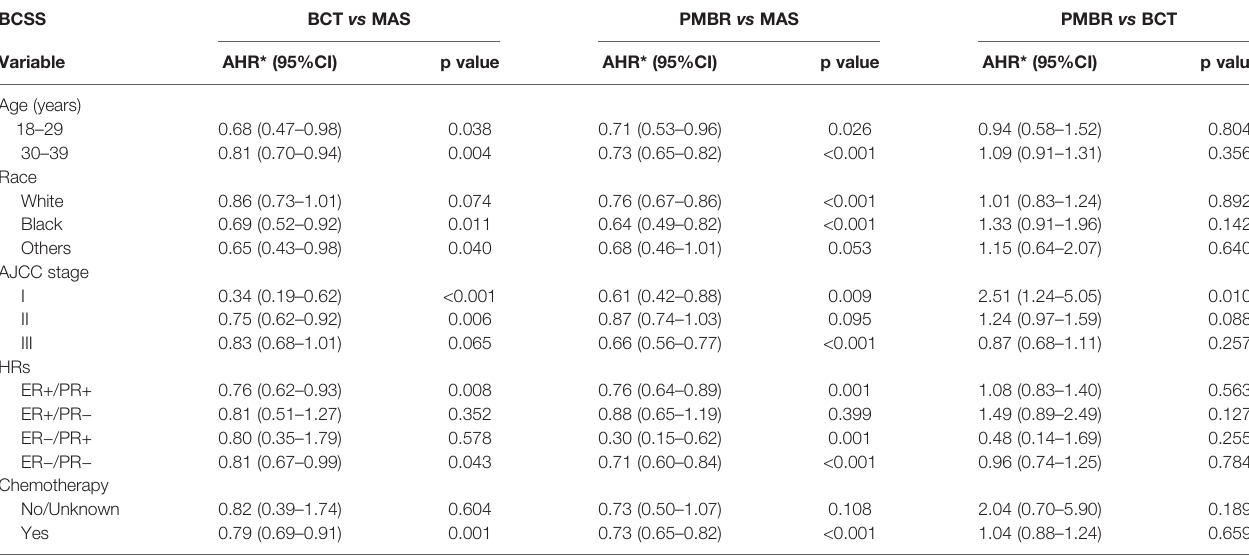
TABLE 3 | Effects of surgery in breast cancer-speci fi c survival by demographic and pathological subgroups. BCSS BCT vs MAS PMBR vs MAS PMBR vs BCT